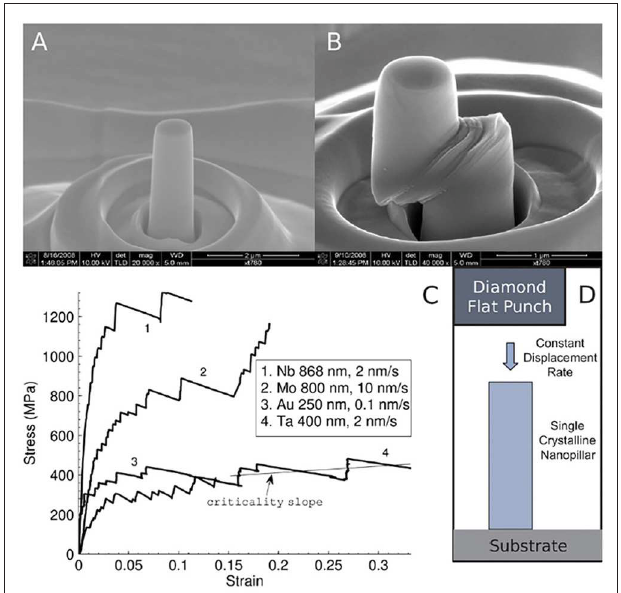
FIGURE 2 | Stress-binned complementary cumulative distribution C(S) of slip sizes S for different bins of applied stress (note that “s” on the horizontal axis in the main figure represents the slip size denoted “S” in the inset and also in this review). The data was obtained from the compression of seven Mo nanopillars of approximate diameter 800nm, compressed at a 0.1 nm/s nominal displacement rate. The inset shows a scaling collapse of the data using the mean-field model predictions κ = 1.5 and σ = 0.5 onto the predicted mean-field scaling function shown in gray. For details, see [4] and